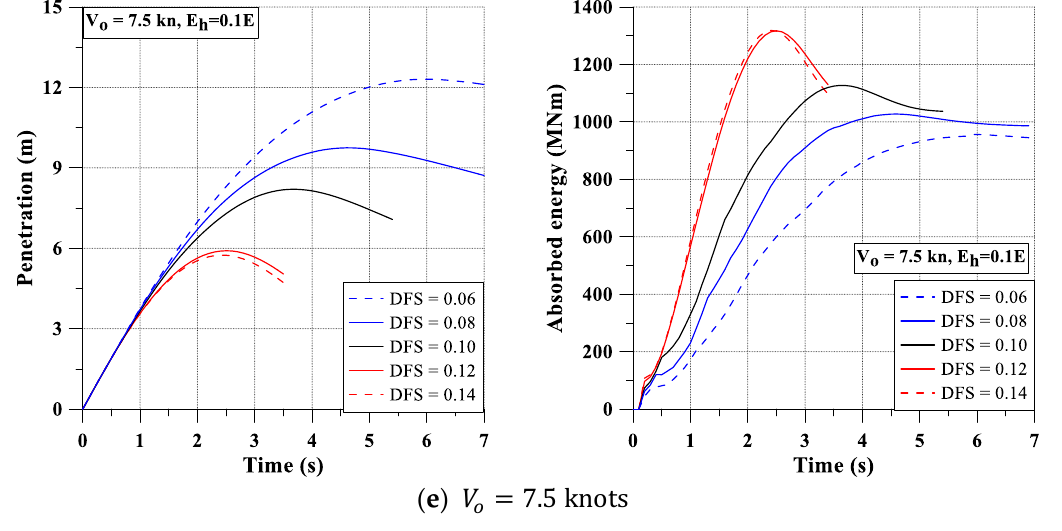
Figure 8. Effect of DFS on dynamic structural responses depending on 𝑉 𝑜 with 𝐸 ℎ = 0.1𝐸 .